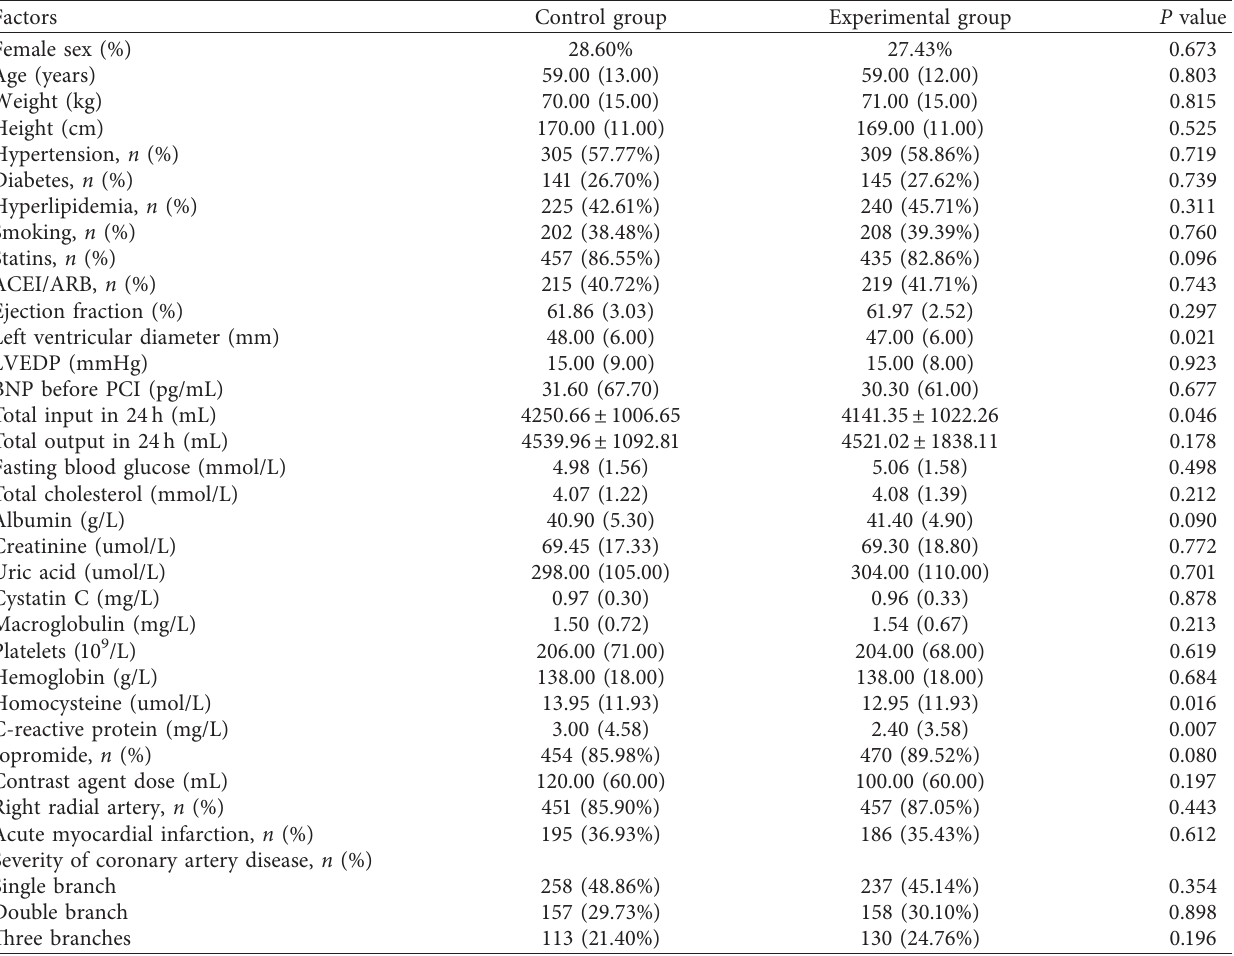
Table 1: Baseline clinical characteristics of all patients.